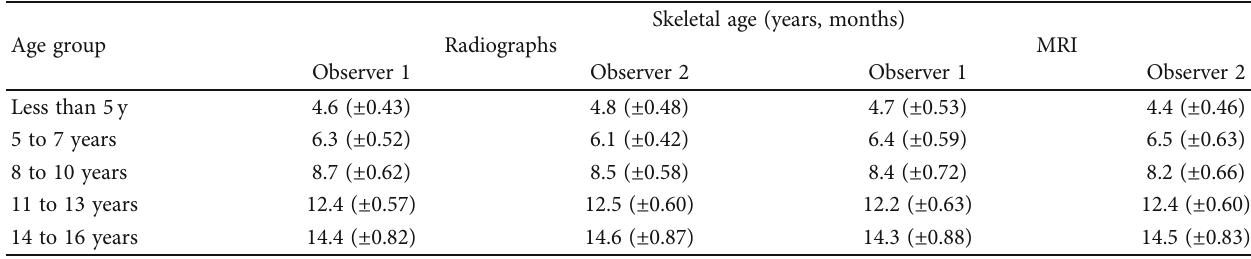
Table 1: The mean skeletal age assessment based on MRI vs. radiographs.